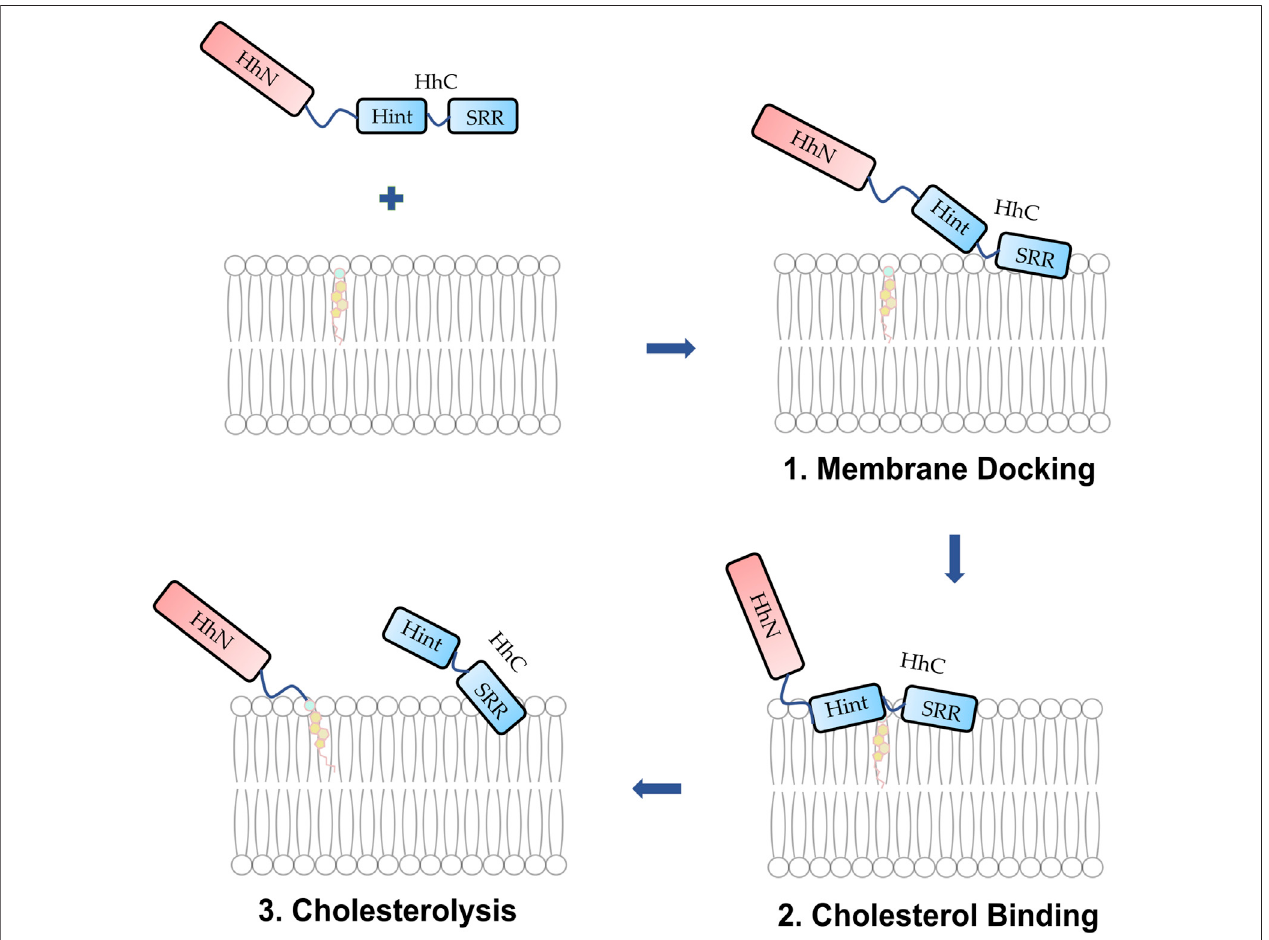
FIGURE 9 | Proposed mechanism of membrane docking, cholesterol binding, and cholesterolysis. ( 1 ) The Hh protein docks to the membrane. ( 2 ) The SRR cooperates with the Hint enabling cholesterol to access the thioester. ( 3 ) Cholesterolysis proceeds followed by the generation of Hh ligand.